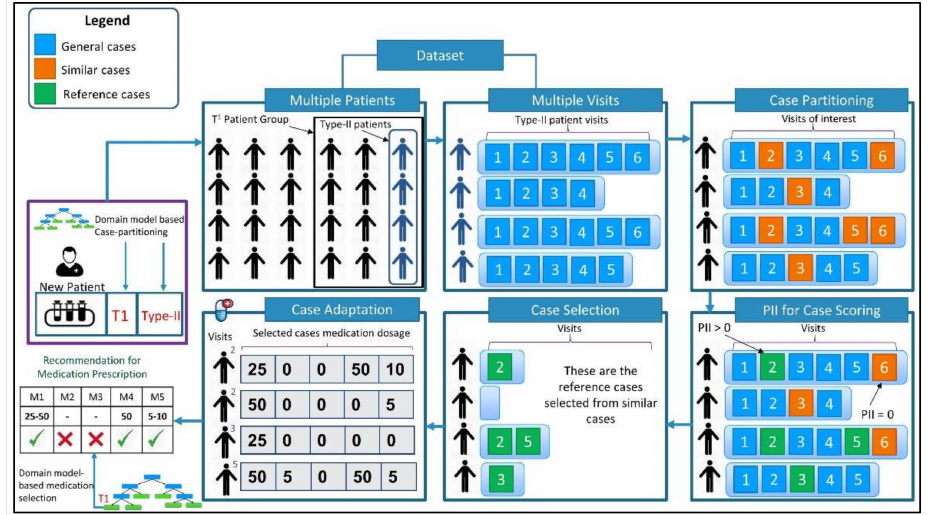
Figure 4. Medication selection and dosage adjustment scenario based on the proposed approach.